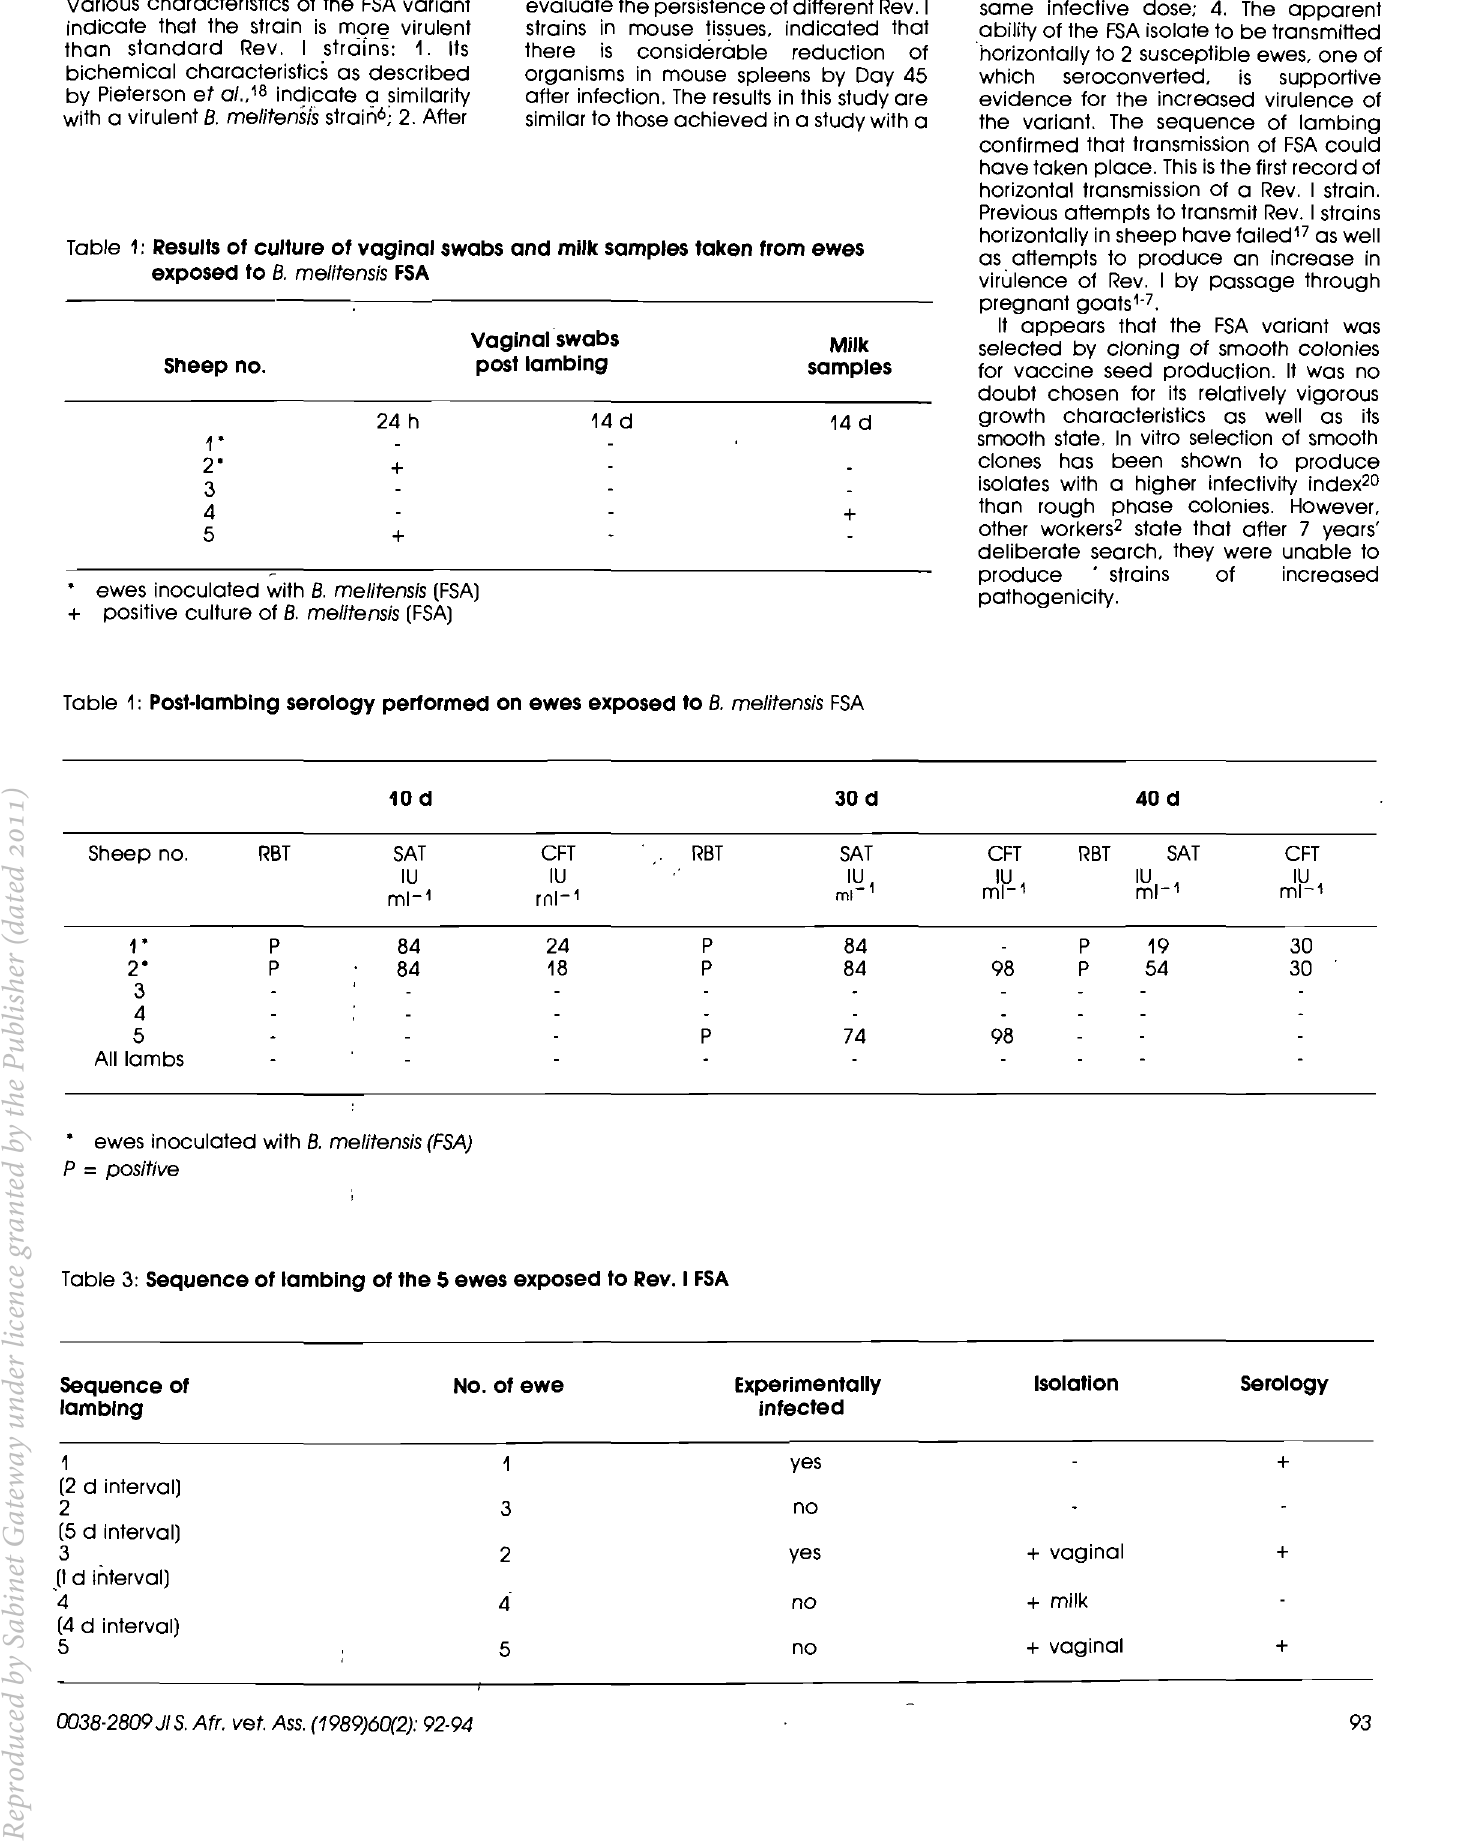
Table 1: Results of culture of vaginal swabs and milk samples taken from ewes exposed to B. melitensis FSA